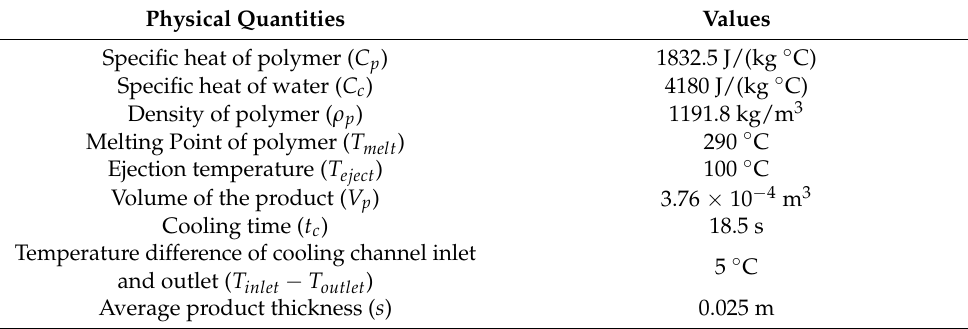
Table 1. Physical quantities are required to calculate the minimum flow rate